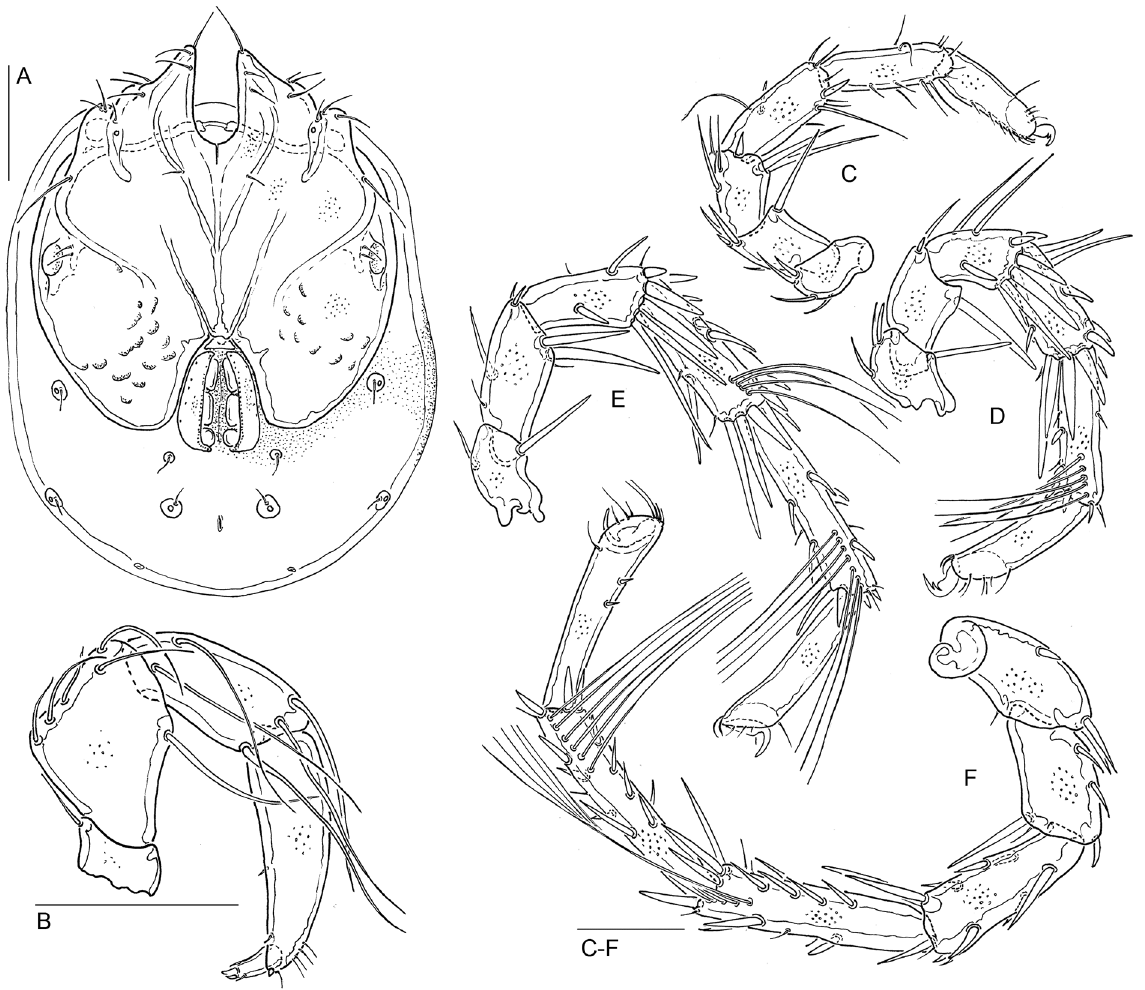
Fig. 9. Lebertia ( Pilolebertia ) gibbosa Lundblad, 1926, holotype, ♂ (NHRS). A . Venter. B . Palp. C . I-L. D . II-L. E . III-L. F . IV-L. Scale bars = 100